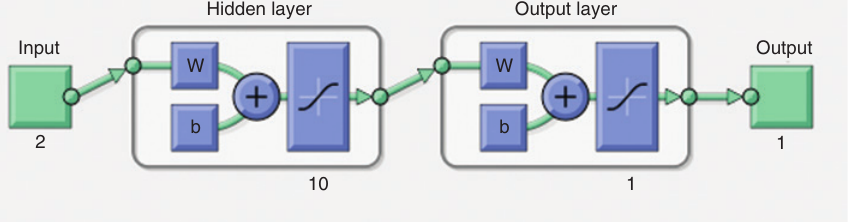
Figure 10: Model of artificial neural networks (2-10-1).